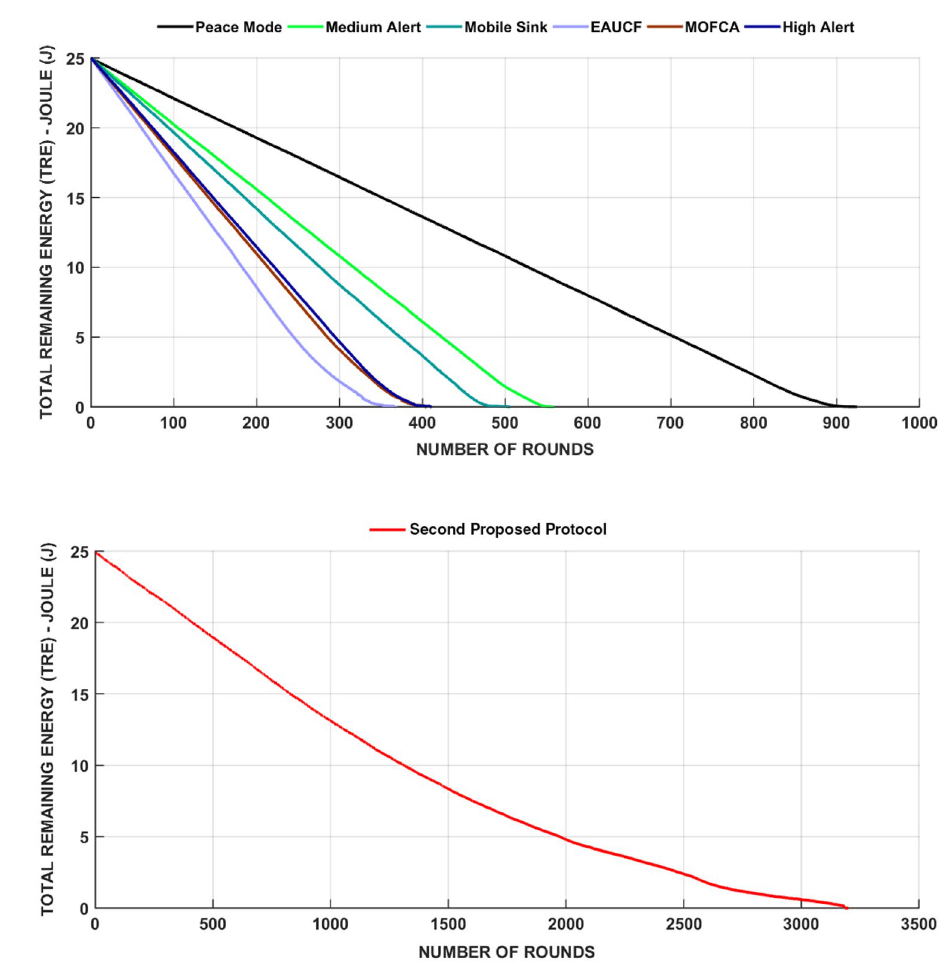
Fig. 11 Total remaining energy in relation to the number of